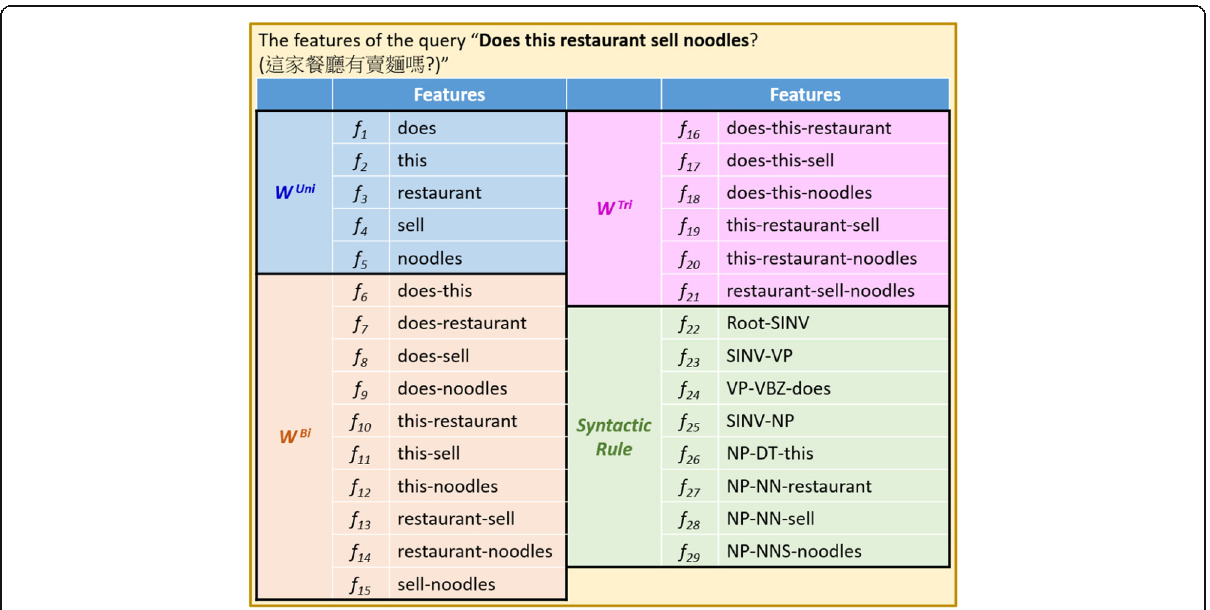
Fig. 7 A feature example for the query “ Does this restaurant sell noodles? ( 這 家 餐 廳 有 賣 麵 嗎 ?) ”